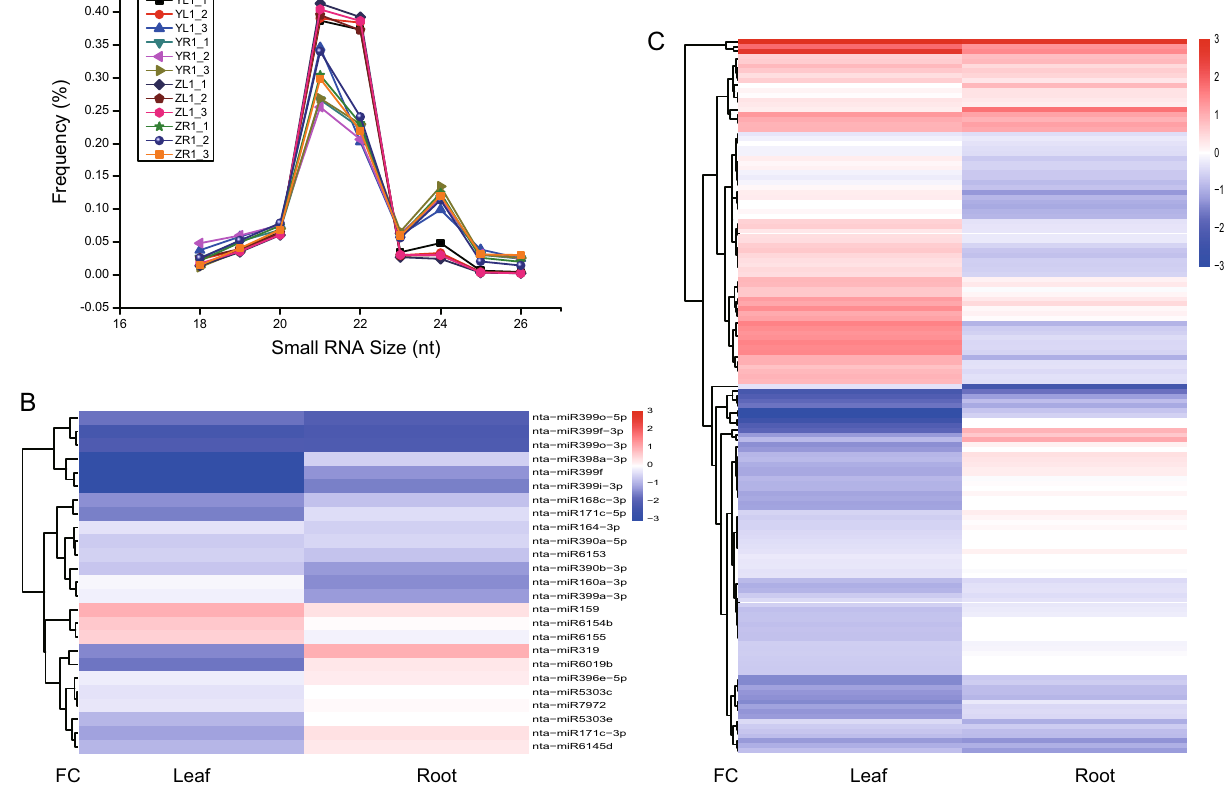
Figure 3. Expression pattern of conserved and novel miRNAs. ( A ) Length distribution of the small RNAs in different libraries. ( B ) Hierarchical cluster analysis of known miRNAs. ( C ) Hierarchical cluster analysis of novel miRNAs. FC fold change, X-axis represents fold change between two